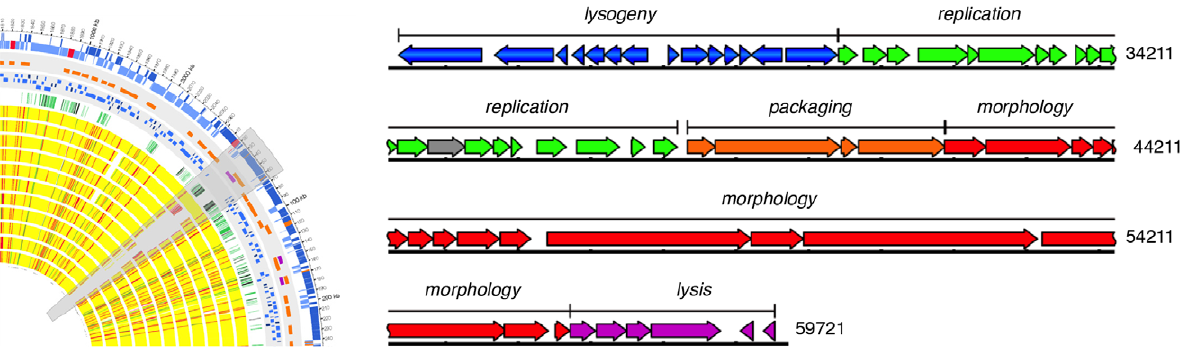
Figure 6. Genomic location and structure of prophage in PNI0373. The inset depicts the genomic location of the identified prophage, w PNI0373, and highlights other features in the region across the genomes analyzed. The predicted modular structure of w PNI0373 is shown with the gene content and orientation for each unit indicated. doi:10.1371/journal.pone.0026742.g006 PLOS ONE |